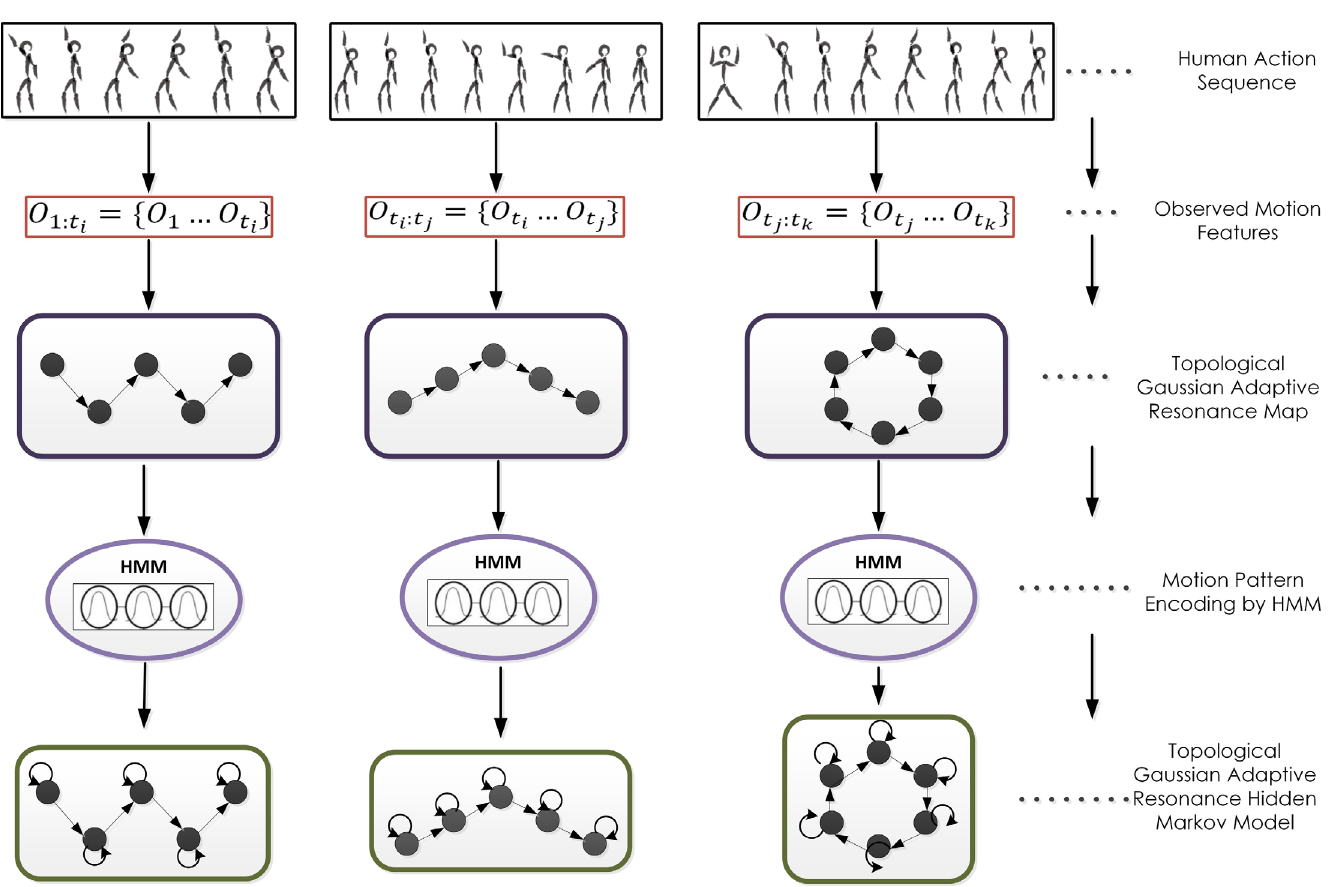
Fig 4. Overview of TGAR-HMM learning architecture. The observed behaviour sequence is first arranged through topological map. This topological map is then used to update the state structure for estimating the optimal number of states and the transition probabilities among these